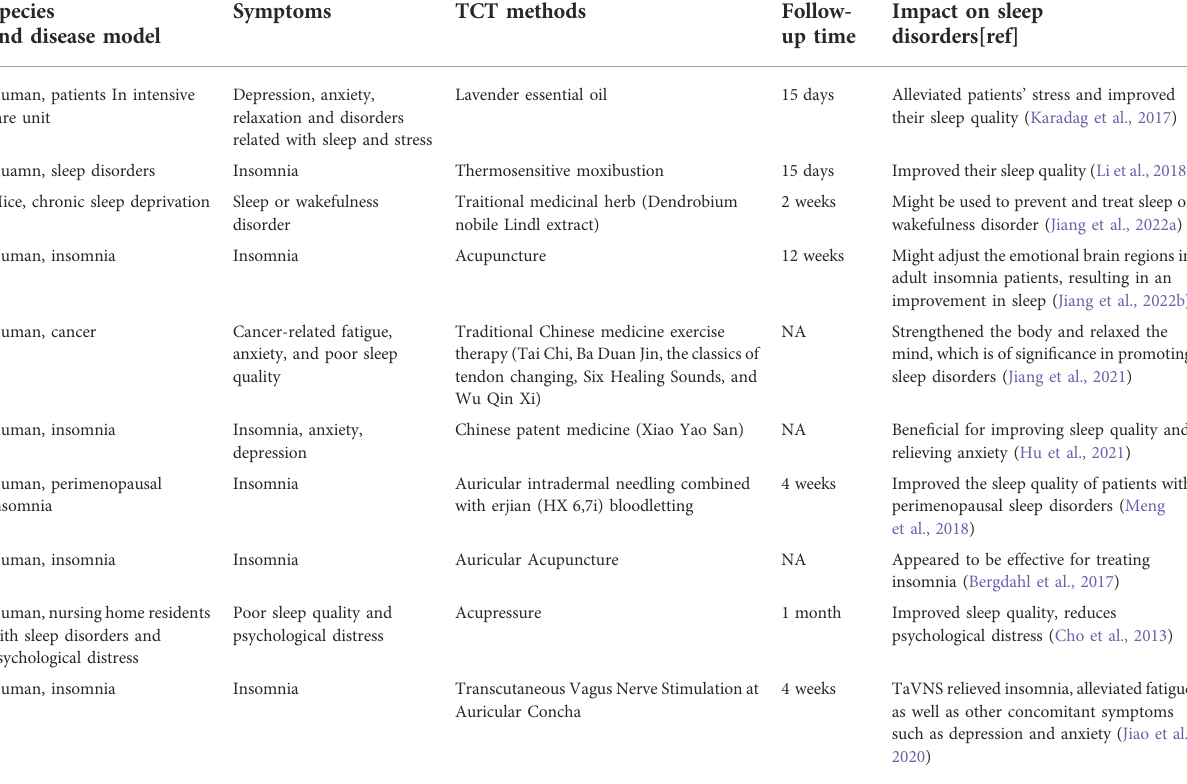
TABLE 3 Summary for the effect of TCT on the sleep